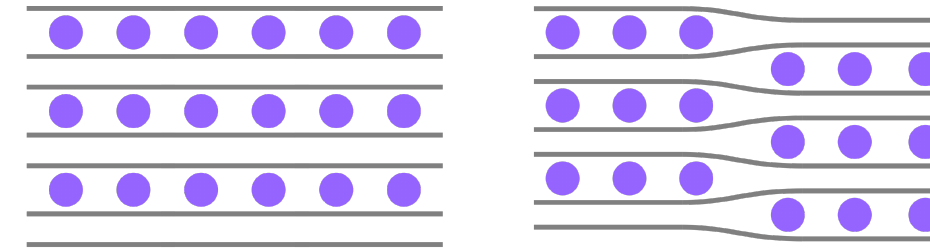
Figure 1. Stage 2 Li-GIC compound (purple: Li-ions, gray: graphene sheets) in a global staging model ( left ) and the Daumas–Heróld domain model ( right